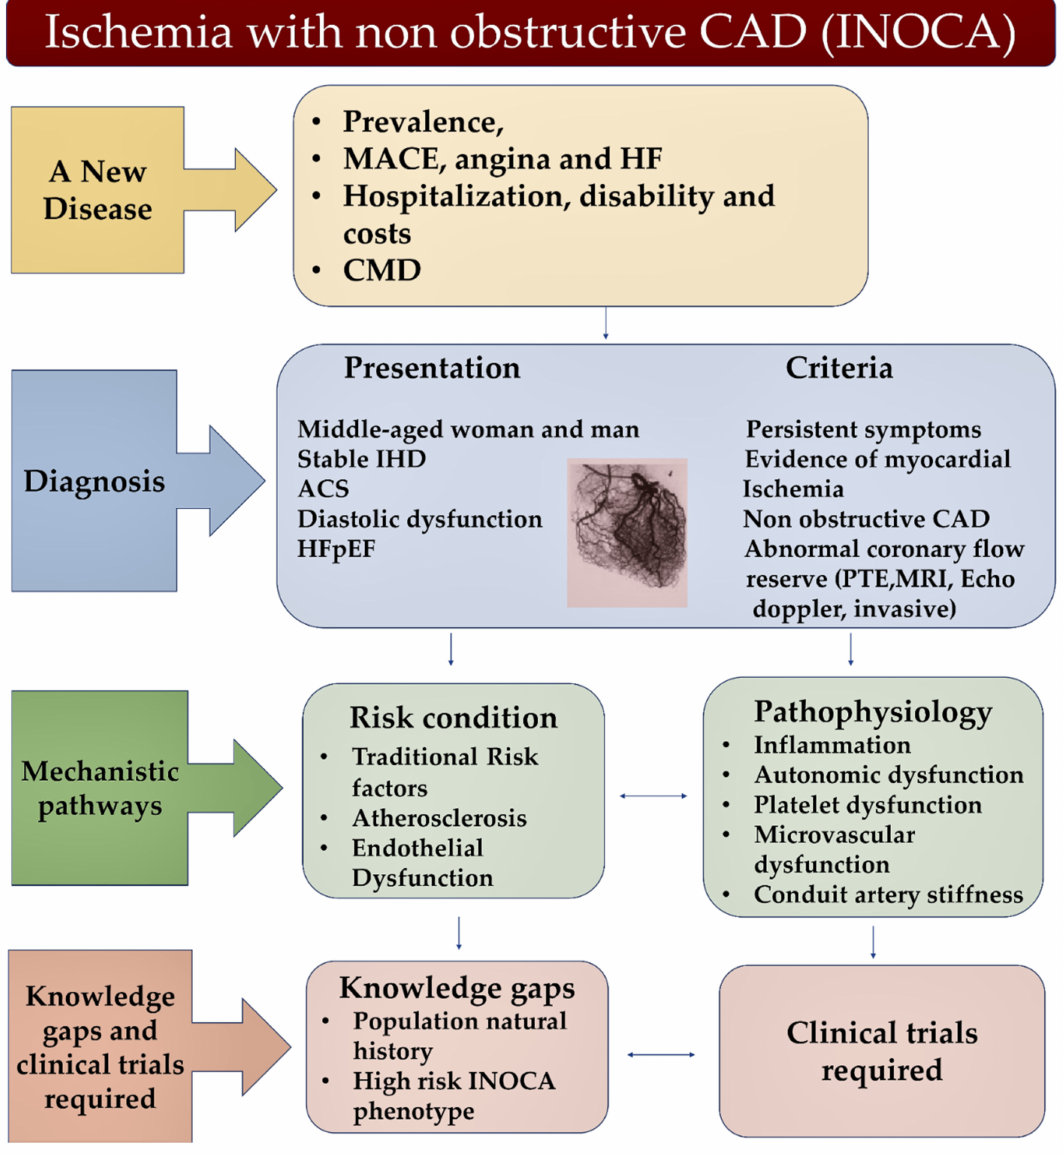
Figure 4. Ischaemia with nonobstructive CAD also called INOCA is a new disease (yellow box) characterized by a specific diagnosis accompanied by typical presentation and criteria (blue box). Risk condition and pathophysiology (green box), as well as an improvement of knowledge (brown box) are of primary importance for the management of INOCA. Abbreviations; IHD; ischaemic heart disease; MRI, Magnetic Resonance Imaging; positron emission tomography; other abbreviations in other figures and